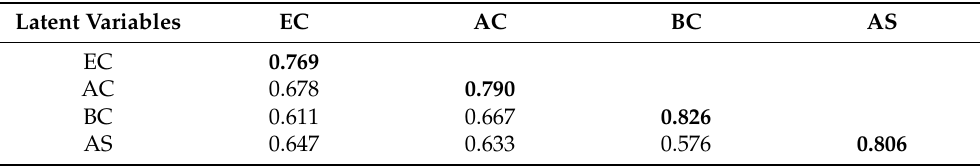
Table A2. Discriminant validity-Fornell–Larcker criterion.